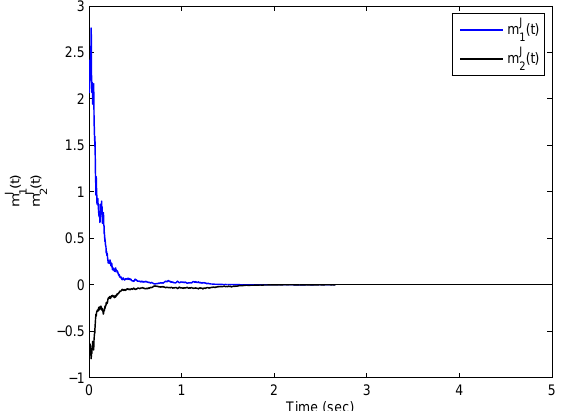
( t ) , m J ( t ) pertaining to the SMQVNN 2 1